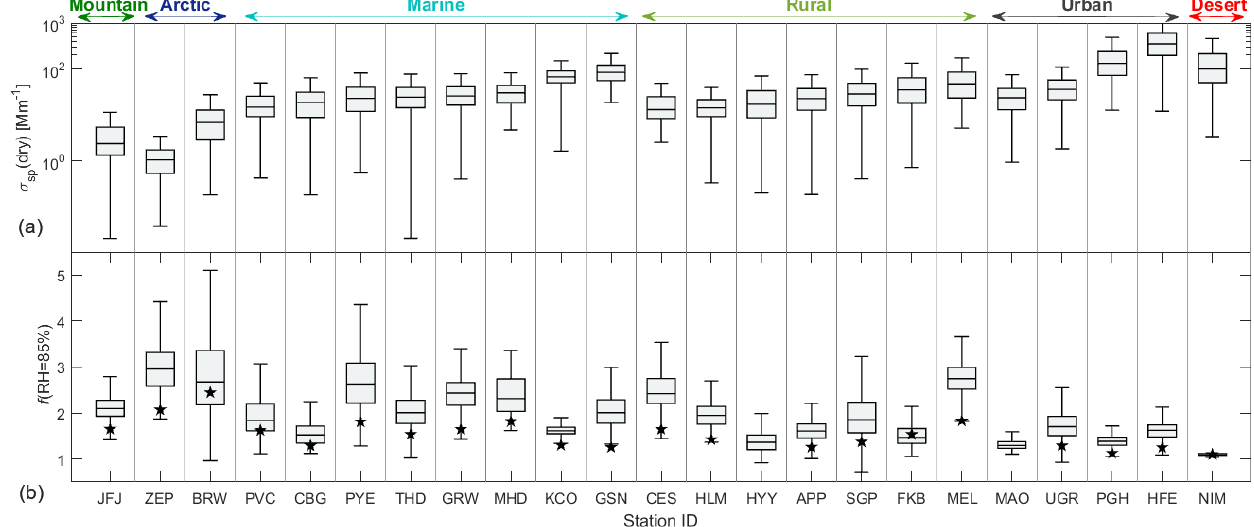
Figure 1. Box plot of dry scattering coefficient (a) and f (RH = 85%) (b) at λ = 550nm ( λ = 525nm at HYY) . The black stars in the lower panel indicate the median backscattering enhancement factor f b (RH = 85%). Sites are sorted by site type and scattering coefficient (from low to high). For each box, the central mark is the median, the box extends vertically between the 25th and 75th percentiles, and the whiskers extend to the most extreme data that are not considered